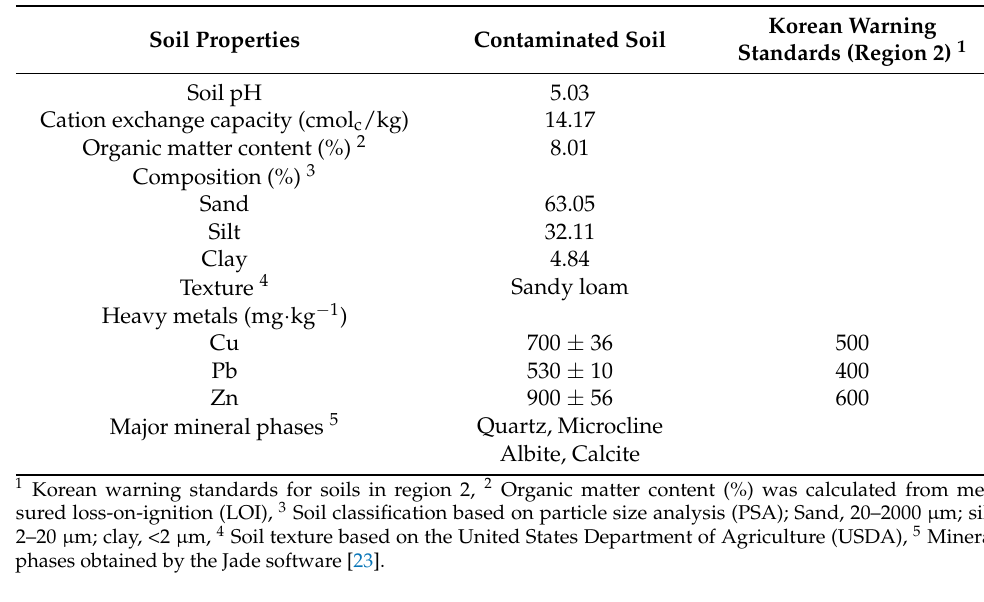
Table 1. Soil characterization results.